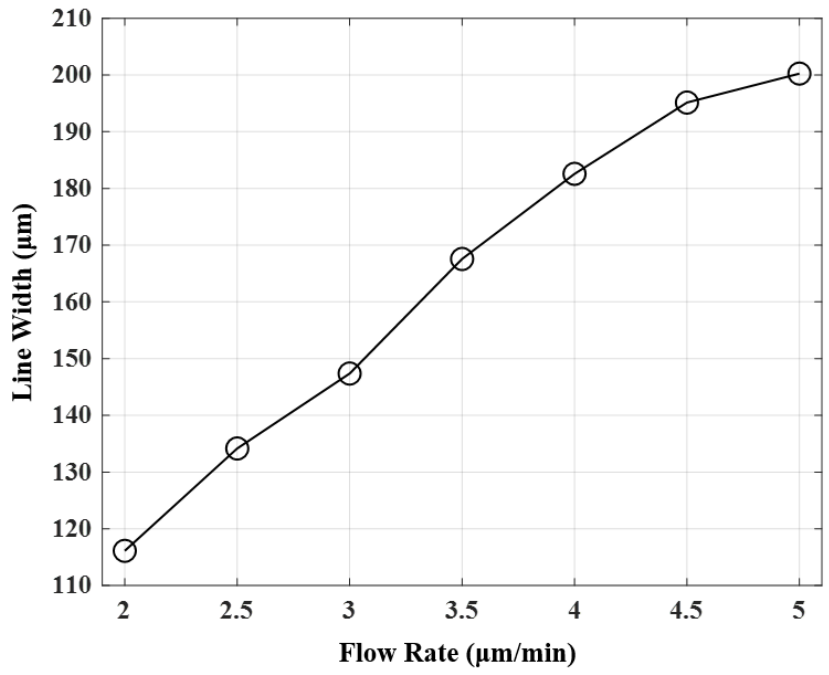
Figure 8. Line widths that were obtained for different flow rates during EHD inkjet